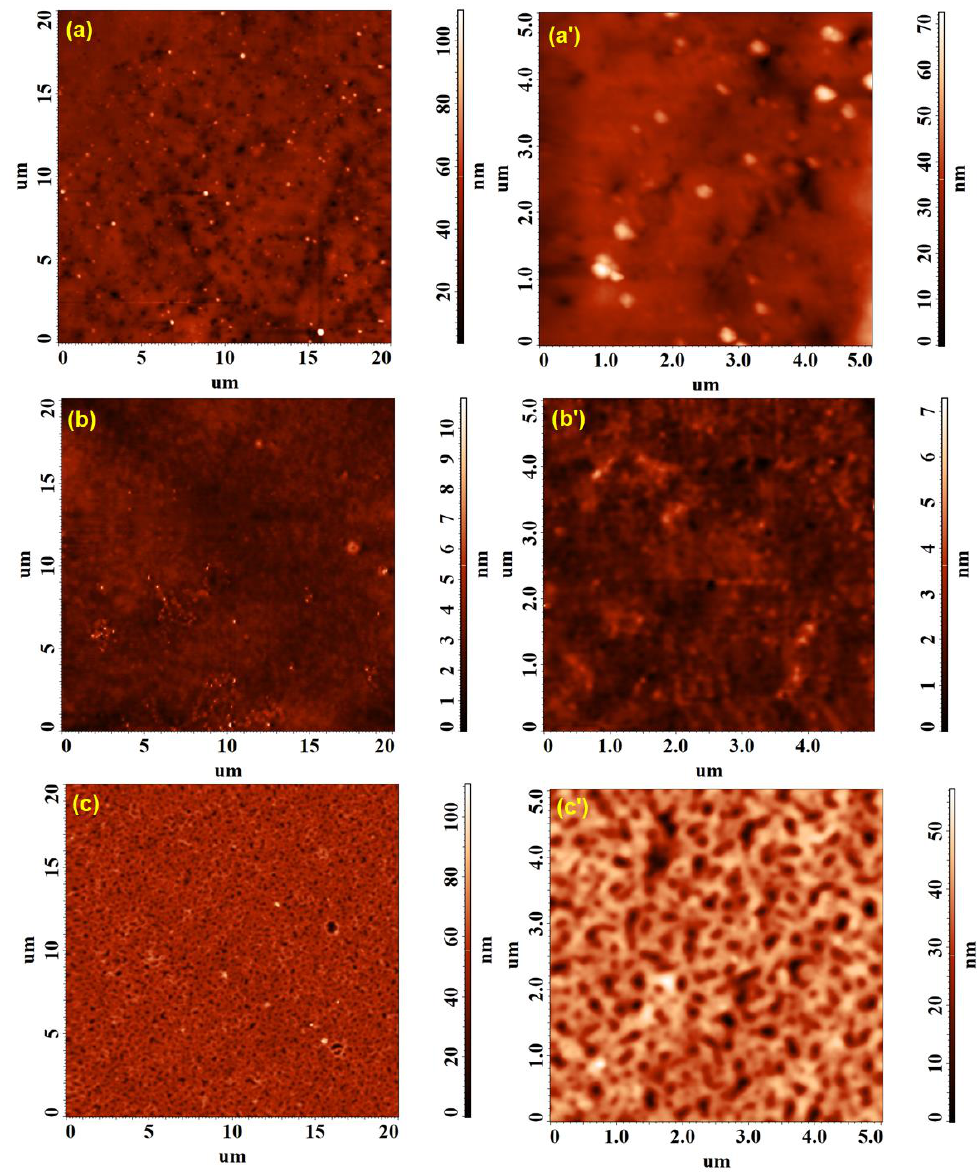
Figure 9. AFM topographical images collected on 20 × 20 µm 2 and 5 × 5 µm 2 for HPMC-AgNPs ( a , a ′ ), PVP-AgNPs ( b , b ′ ) and HPMC/PVP-AgNPs ( c , c ′ ) samples after incorporating Ag nanoparticles.